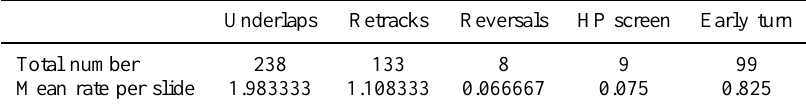
Table 1 Scanning track errors; frequency by type of